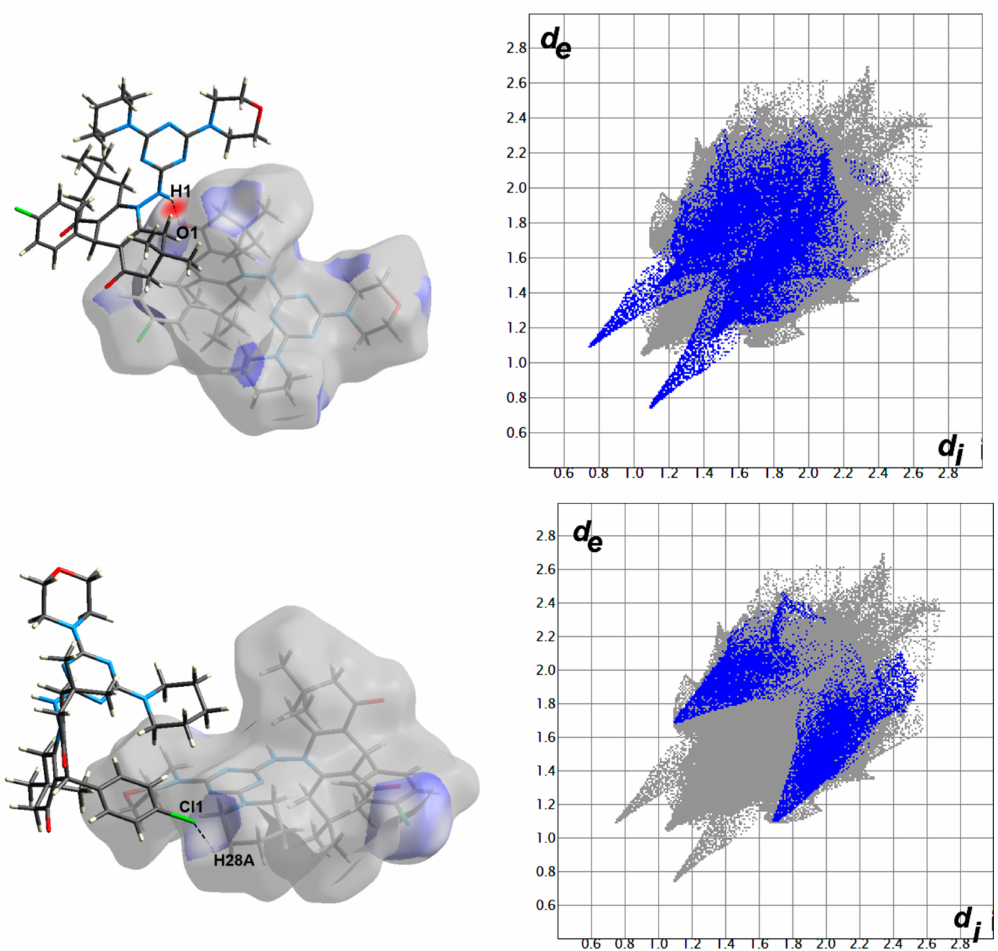
Figure 5. The d norm maps ( left ) and FP plots ( right ) of the O1 ... H1 (1.831 Å) and Cl1 ... H28A (2.791 Å) contacts in the studied